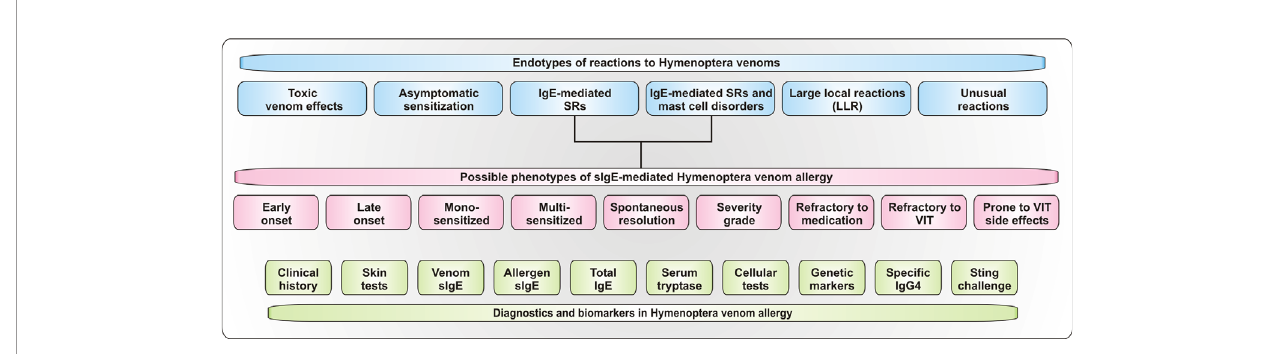
FIGURE 2 | Endotypes und Phenotypes of reactions to Hymenoptera stings. Depicted are proposed endotypes of reactions to Hymenoptera venoms as well as of proposed phenotypes of IgE-mediated systemic allergic reactions. Additionally, available diagnostic tools and biomarkers for the assessment of the reaction are shown. SRs,